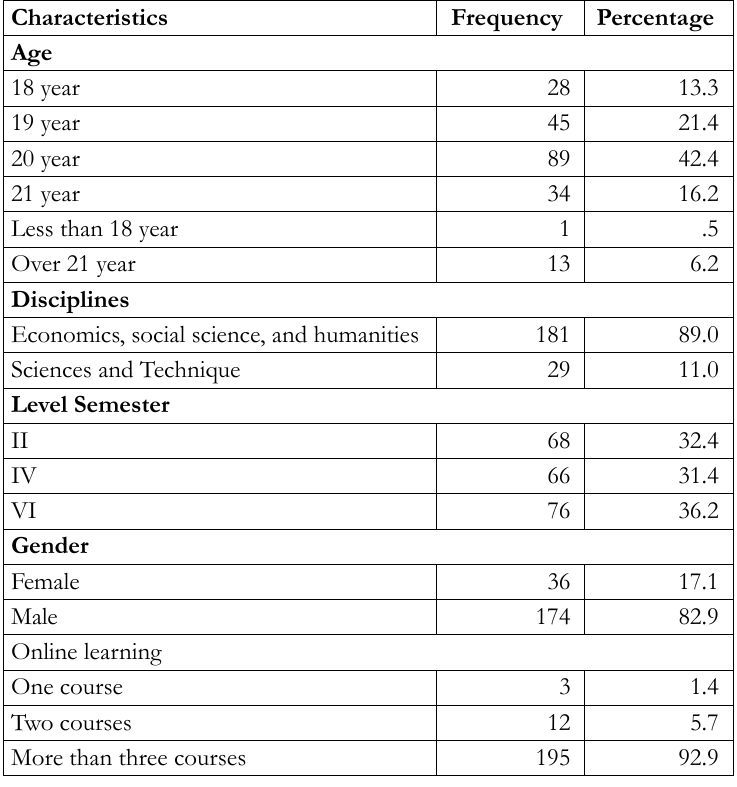
Table 1. The Profile of